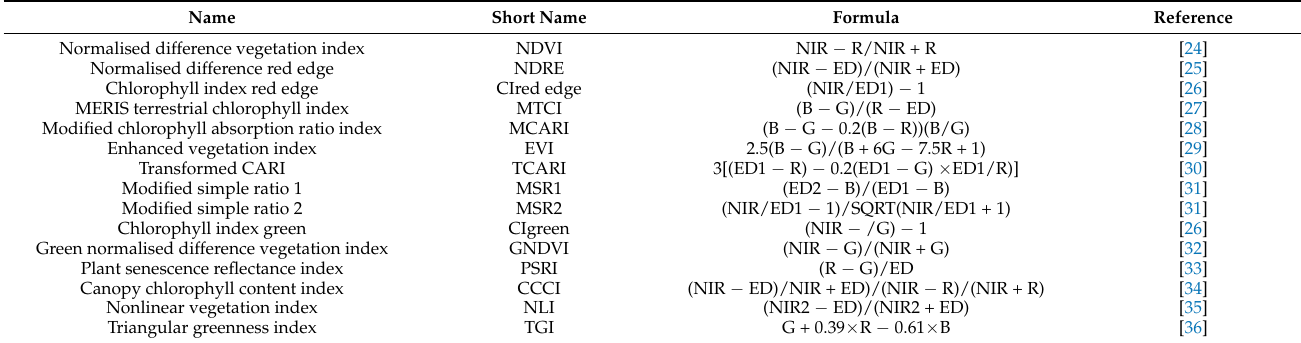
Table 2. Vegetation indices compiled from the